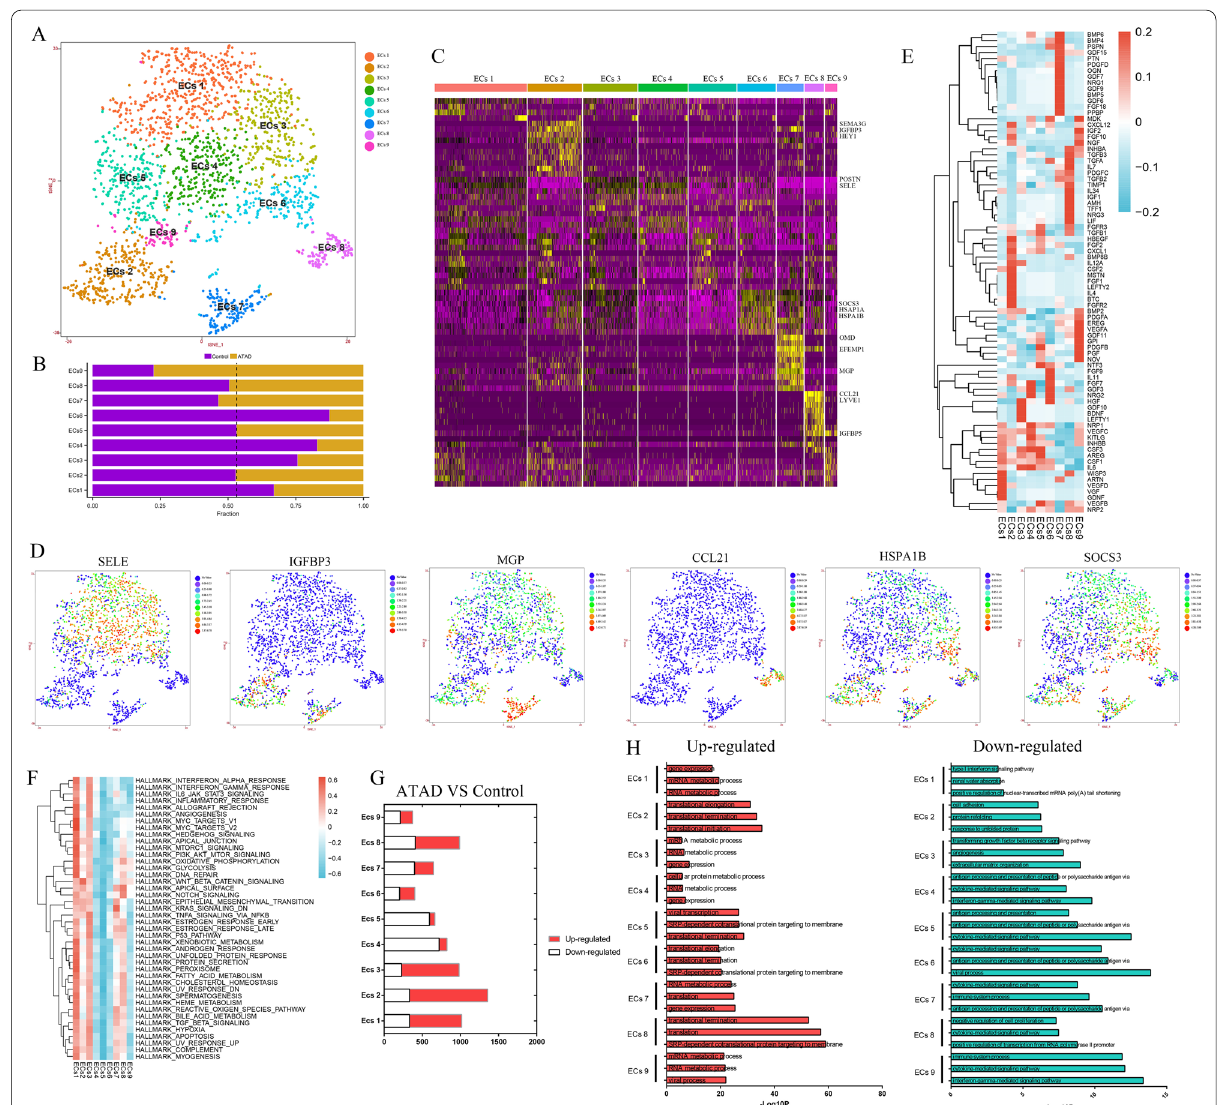
Fig. 3 Nine subpopulations of ECs were obtained upon re‑clustering with distinct markers and functions. A t‑SNE plot showed 9 subpopulations of ECs. B The proportion of each subpopulation of ECs between control and ATAD group. The dashed line marked off the dominant subpopulations in ATAD and control group. C Heatmap of marker genes for each subpopulation of ECs. D t‑SNE plots showed the expressions of representative marker genes for each subpopulation for ECs. E The expressions of growth factors for each subpopulation of ECs. F Qusage analysis of hallmark gene‑sets enrichment for each subpopulation of ECs. G DEGs in subpopulations of ECs (ATAD/Control). H GO analysis for up‑regulated and down‑regulated genes in subpopulations of ECs